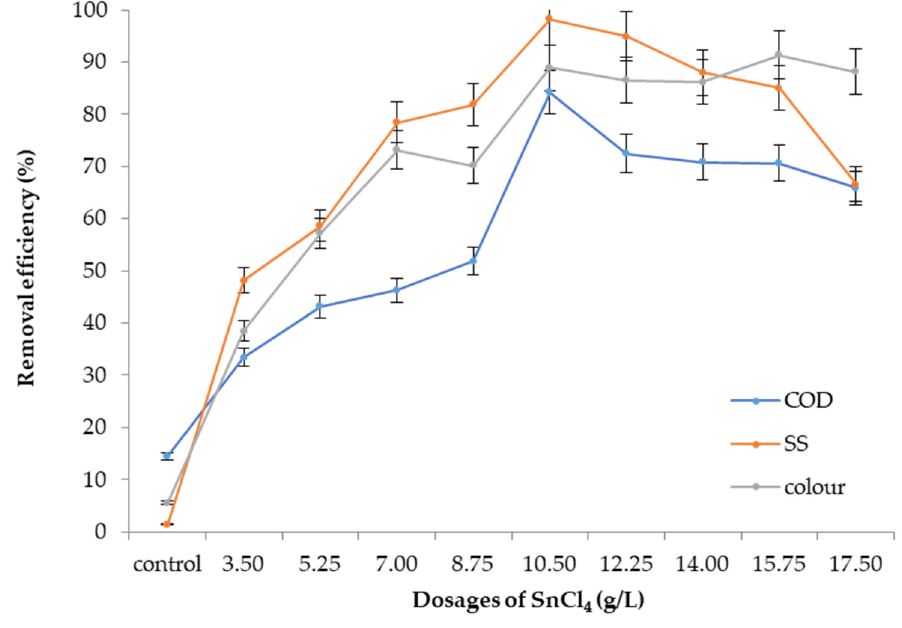
Figure 9. SS, colour, and COD removal efficiency with varied SnCl 4 dosages at optimum pH 7.